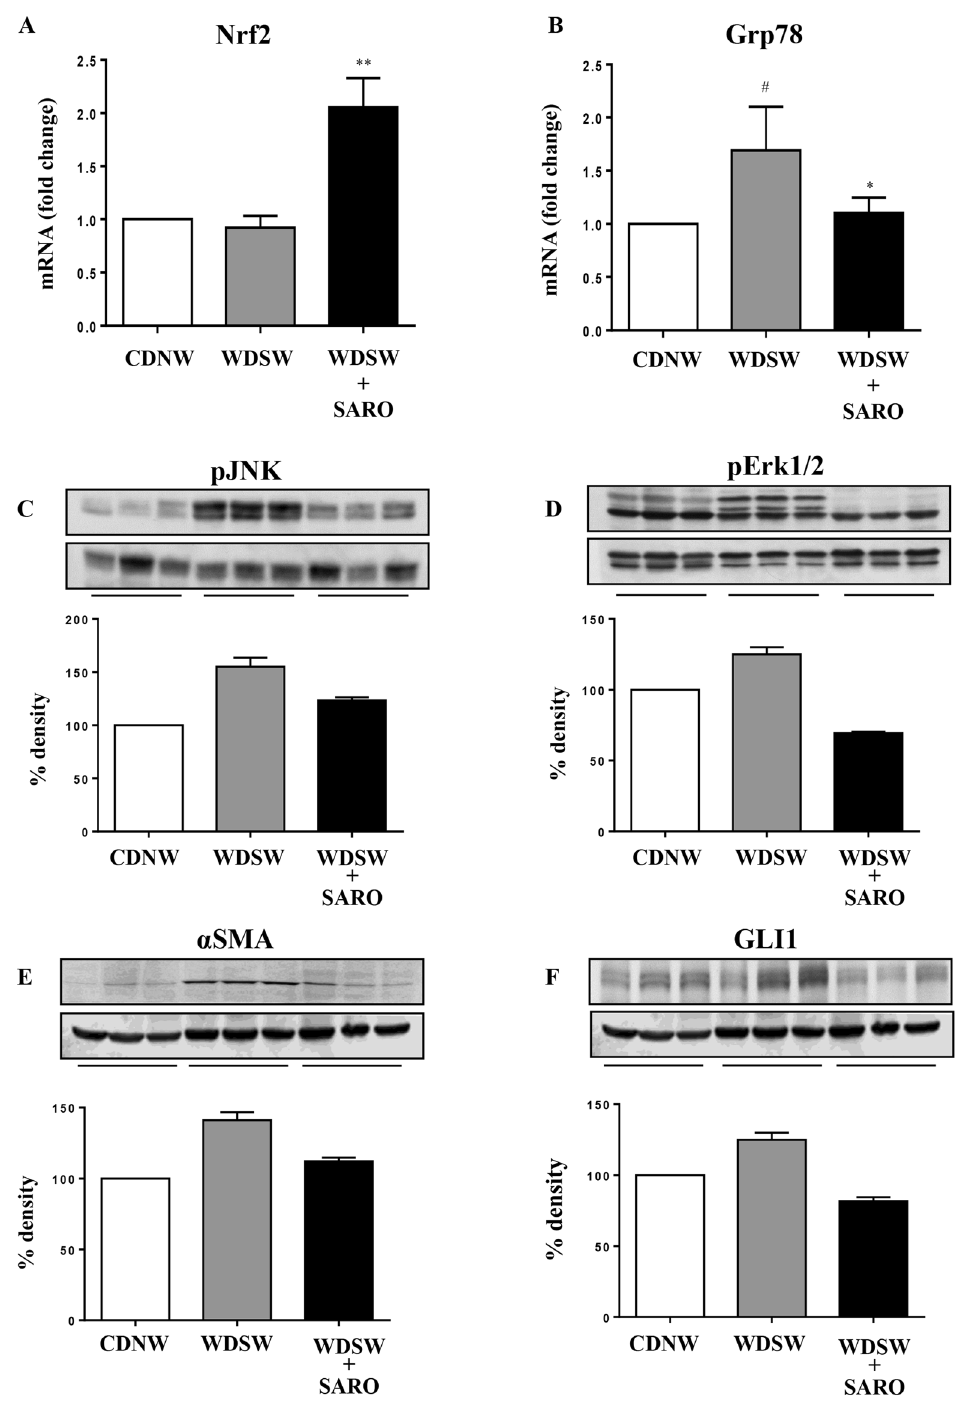
Figure 5. Saroglitazar reduces hepatic ER stress, inflammation and fibrogenic signaling. The relative expression of hepatic mRNA levels of Nrf2 ( A ) and Grp78 ( B ) were determined using TaqMan Q-PCR. The experiments were carried out in triplicates and β -actin was used as endogenous control for normalizing the mRNA levels. Whole cell lysates were prepared from liver tissue of DIAMOND mice treated with saroglitazar or vehicle control for 12 weeks along with CDNW or WDSW, which had developed fatty liver and steatohepatitis. Immunoblot analyses were performed for p-JNK ( C ), p-Erk1/2 ( D ), α SMA ( E ), GLI1 ( F ). Bar graphs show the densitometric values calculated after normalization to loading control, β -actin. Data are expressed as the mean ± SEM for 6–12 mice per group. # p < 0.05 compared to CDNW; ** p < 0.001 compared to WDSW, vehicle control. nrf2, nuclear factor erythroid 2-related factor 2; Grp78, glucose regulated protein 78; JNK, c-Jun N-terminal kinases; Erk1/2, extracellular signal regulated protein kinases 1 and 2; α SMA, alpha smooth muscle actin; GLI1, glioma-associated oncogene homolog 1. Unprocessed original scans of the western blots in C-F are shown in Supplementary Fig.